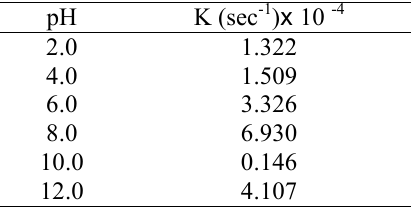
Table 2. Effect of pH on rate